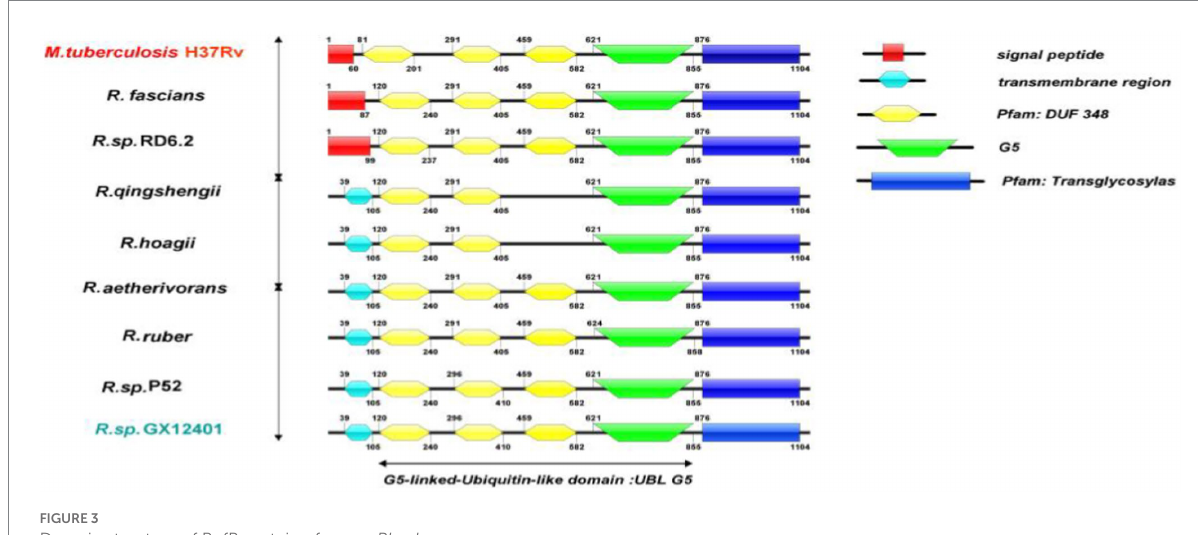
FIGURE 3 Domain structure of RpfB protein of genus Rhodococcus.